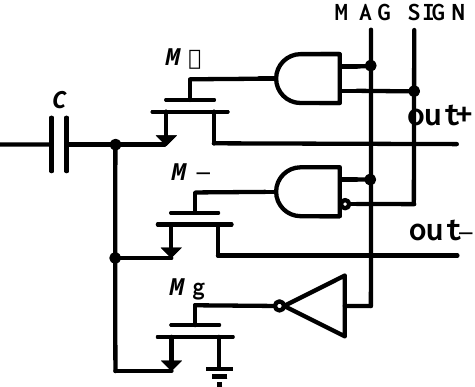
Figure 4. The unit circuit structure of the variable capacitor array.